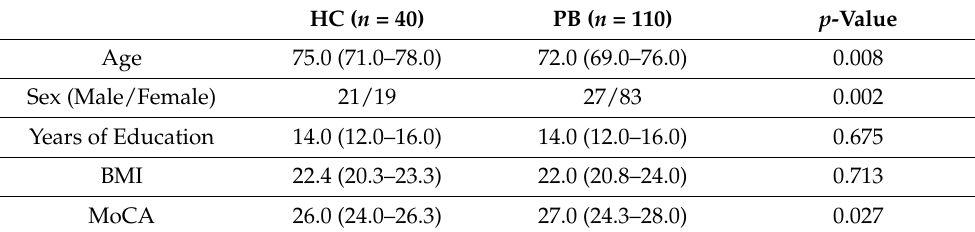
Table 4. Characteristics of Cohort A classified by discriminant analysis